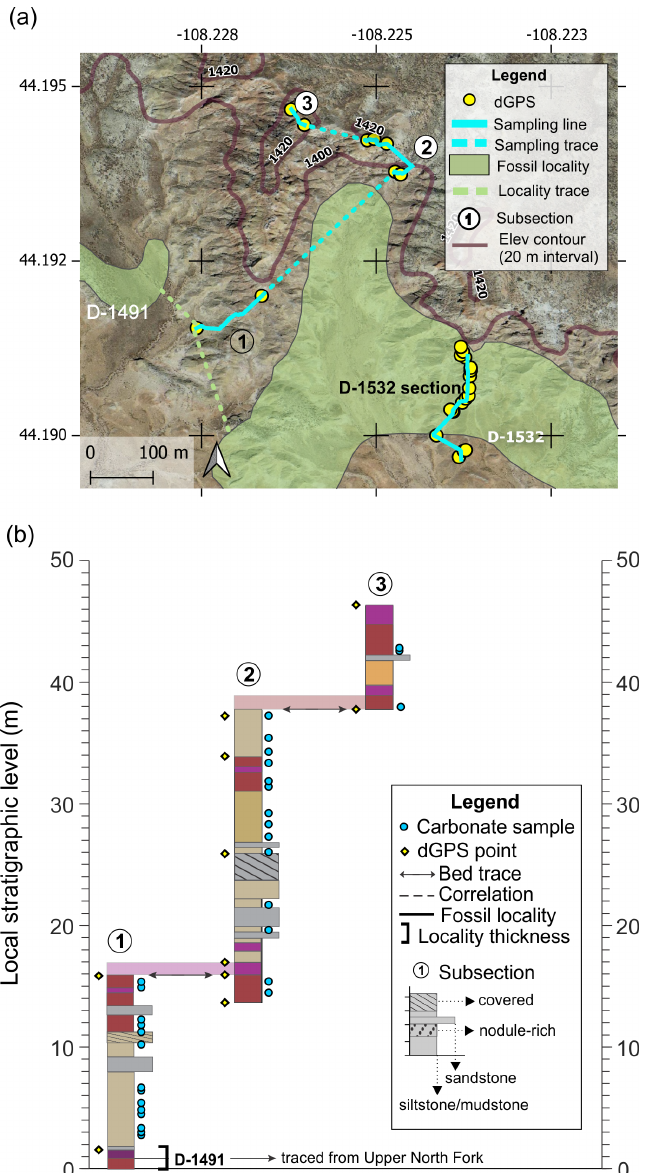
Figure A6. Red Butte section (a) map and (b) diagram showing sampling subsections, dGPS tie points, bed traces, and correlated fossil localities. Colored boxes in (b) represent the surface color of weathered rocks. Marker beds used to trace between subsections are shown in light shading with arrows along the bed surface used for tracing. Basemap source: Google Earth © 2021. A high-resolution map is available in the supplemental data repository (Widlansky et al.,